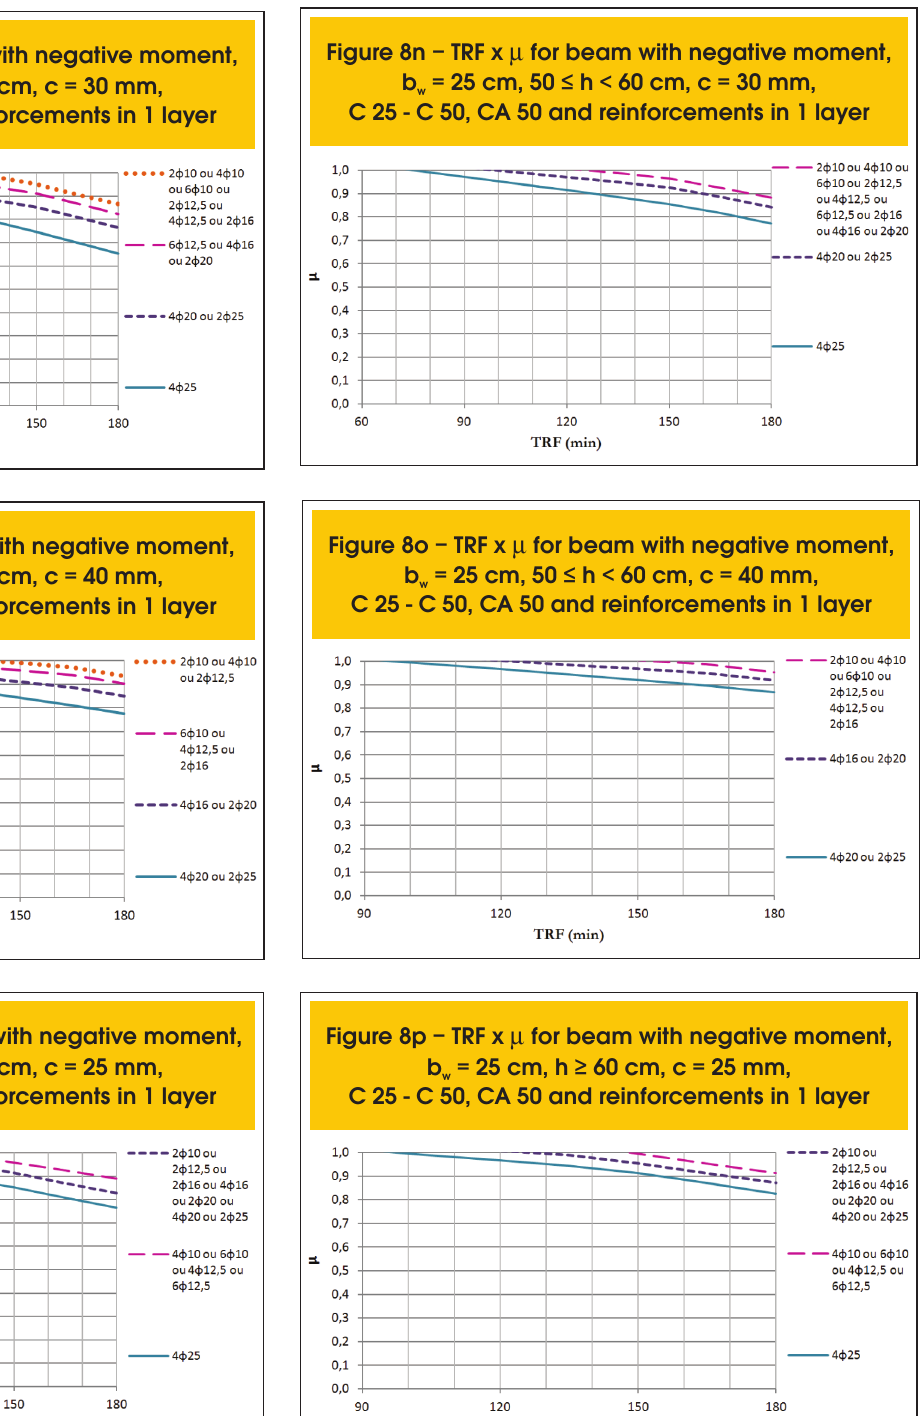
Figure 8n – TRF x m for beam with negative moment, b = 25 cm, 50 ≤ h < 60 cm, c = 30 mm, w C 25 - C 50, CA 50 and reinforcements in 1 layer